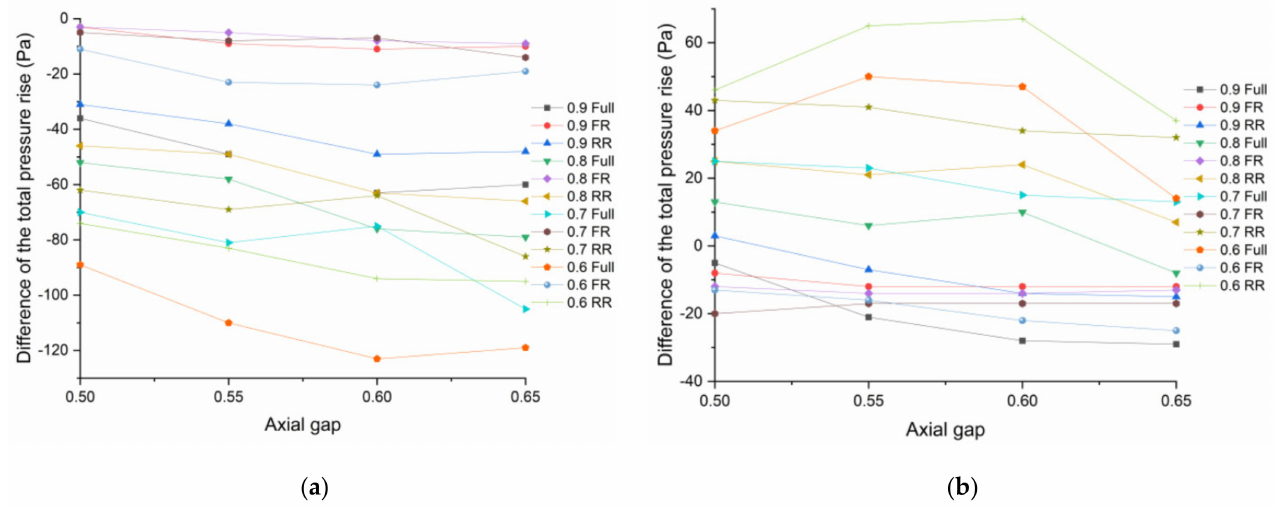
Figure 12. ( a ) Effect of the axial gap on total pressure rise when controlling the FR; ( b ) effect of the axial gap on total pressure rise when controlling the RR.